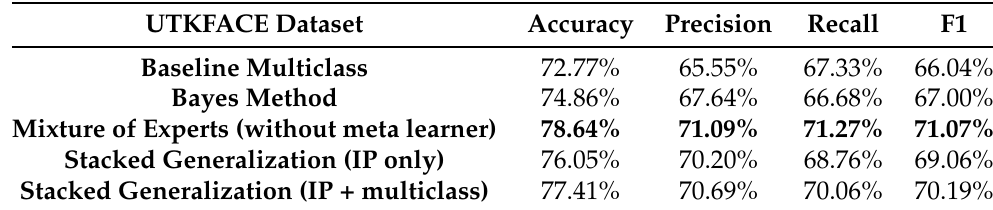
Table 5. Evaluation metrics for the UTKFACE dataset. The highest accuracy metrics are highlighted using